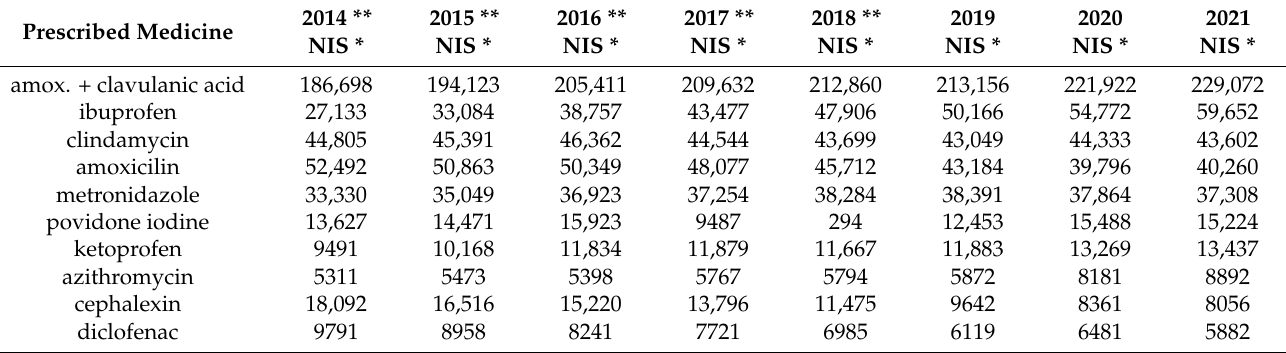
Table 3. Most commonly prescribed medications in dental practice by the annual number of prescrip- tions in